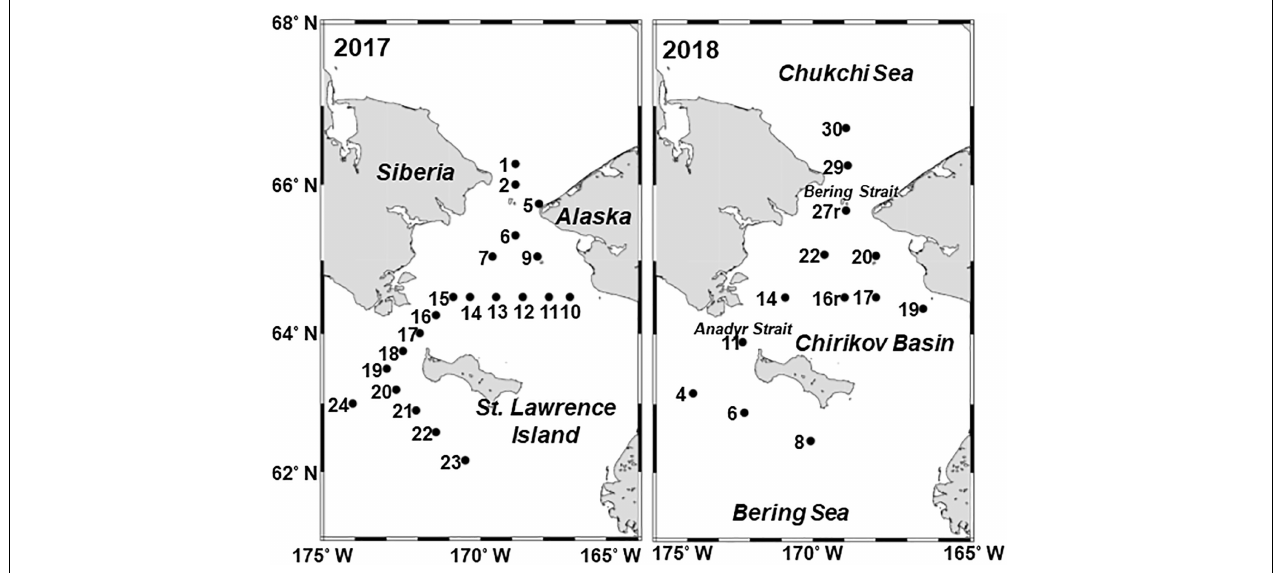
FIGURE 1 | Location of stations in the northern Bering Sea during 11–22 July 2017 and 2–12 July 2018. The numbers indicate the station ID.